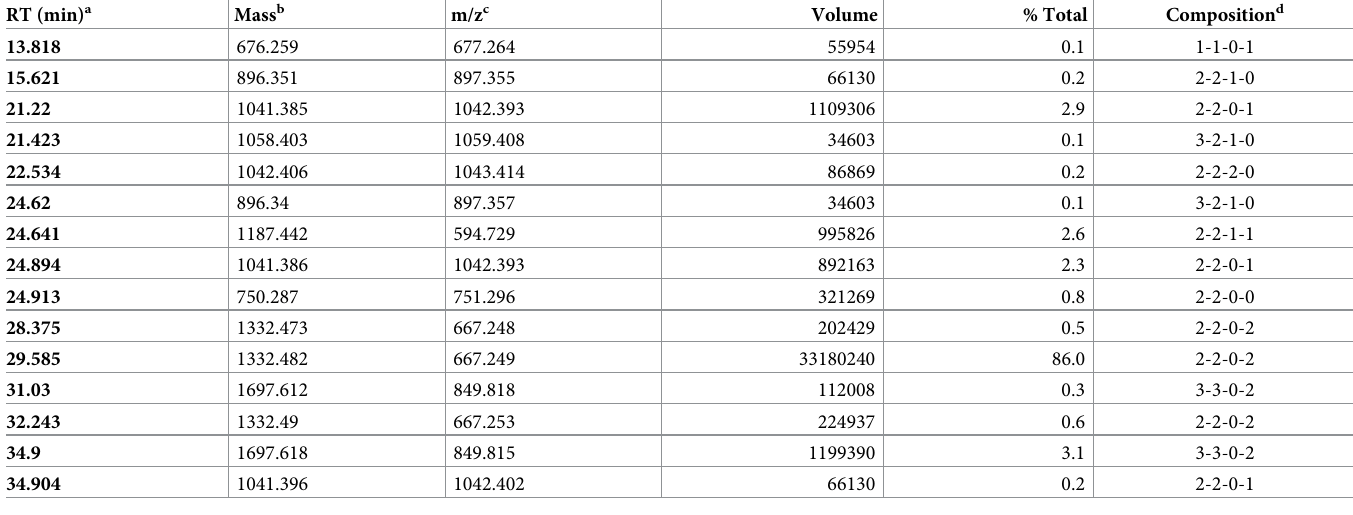
Table 4. Identification by mass spectrometry of O-glycans released from human platelet GPIb α . RT (min) a Mass b m/z c Volume %